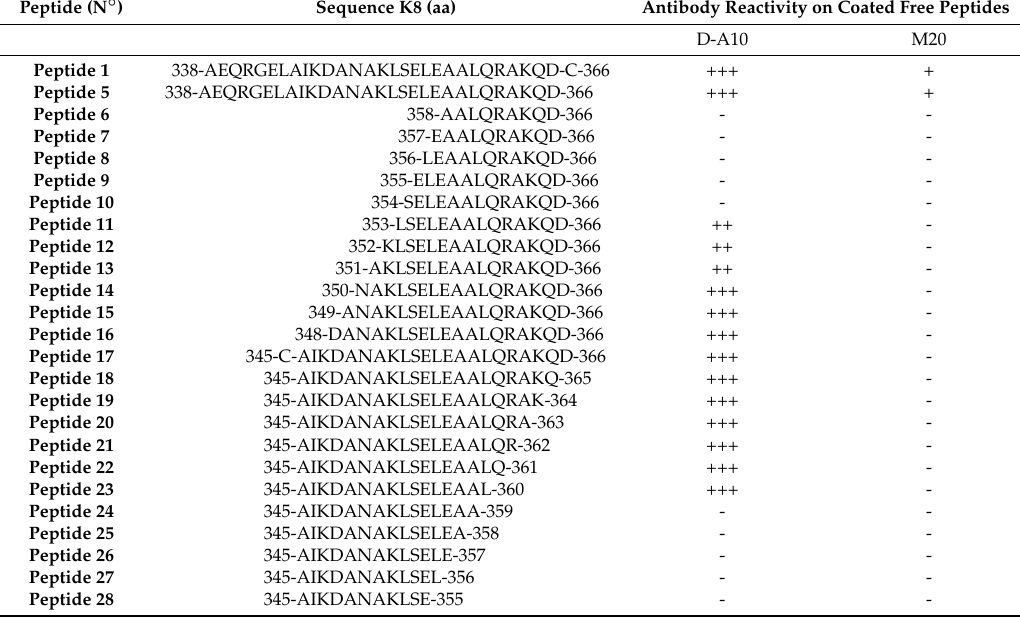
The levels of M20 antibody and D-A10 MAb reactivity to recognize peptides are indicated with the following signs: +++ (strong), ++ (medium), + (weak), or -